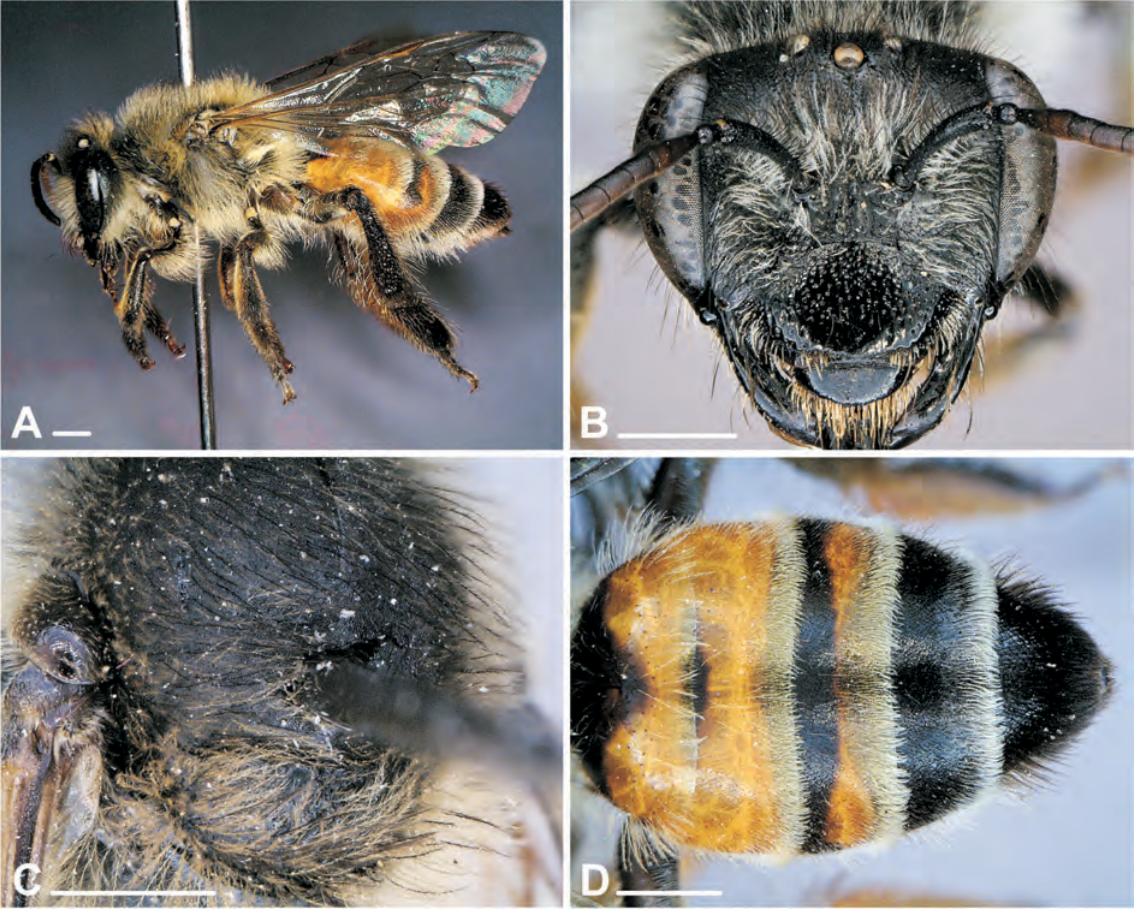
Fig. 2. Redivivoides capensis sp. nov., ♀. A . lateral view. B . head. C . Scutum and scutellum. D . Metasoma (dorsal view). Scale bar: 1